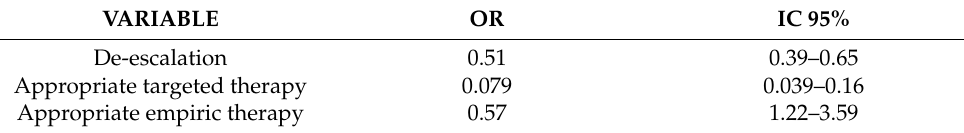
Table 3. Multivariate analysis of factors significantly affecting